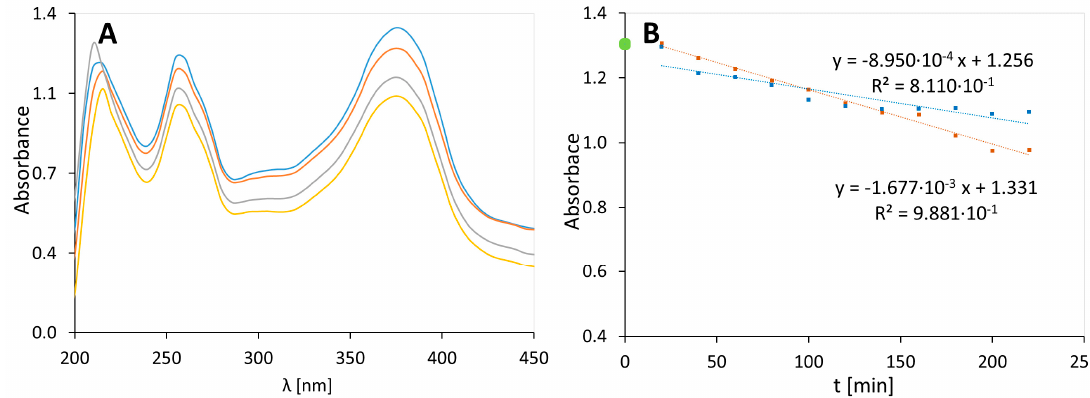
Figure 4. UV-Vis spectra of a methylcellulose (MC) gel with quercetin (preparation 2C), irradiated at 0 ( - ), 80 ( - ), 120 ( - ), and 200 ( - ) minutes ( A ). The graph on the right ( B ) shows the UV degradation of a gel containing a MC polymer and quercetin (orange dots are used for the results of the unexposed samples and blue dots are used for the result obtained of the irradiated